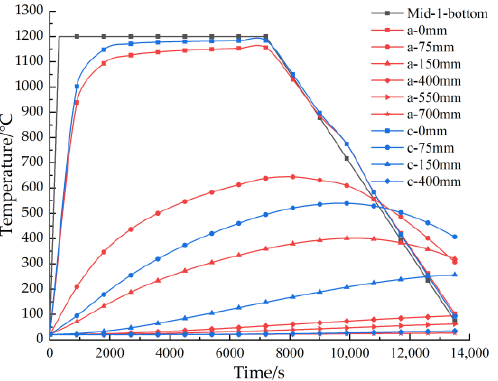
Figure 22. Time-temperature curves of each measuring point in the member without fire prevention measures.